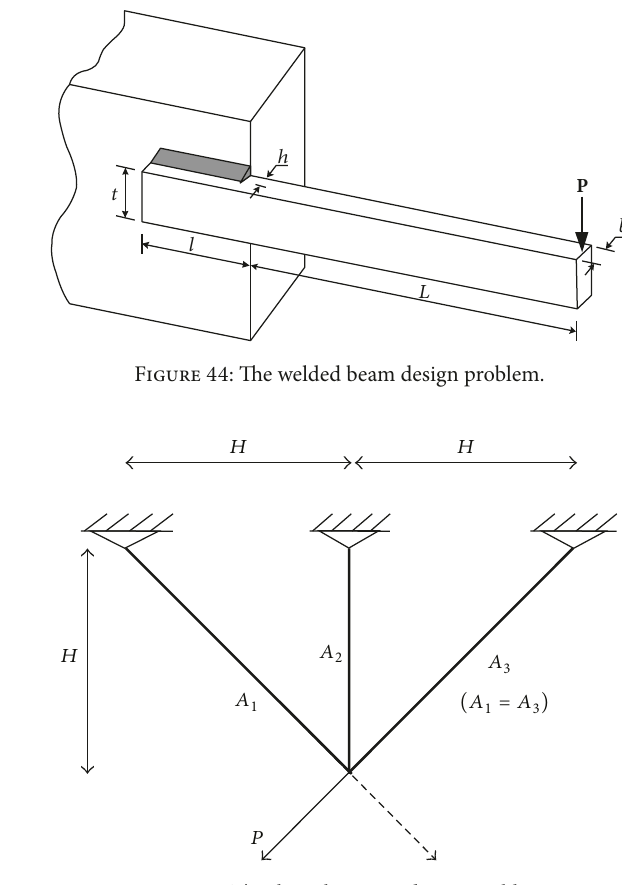
Figure 45: The three-bar truss design